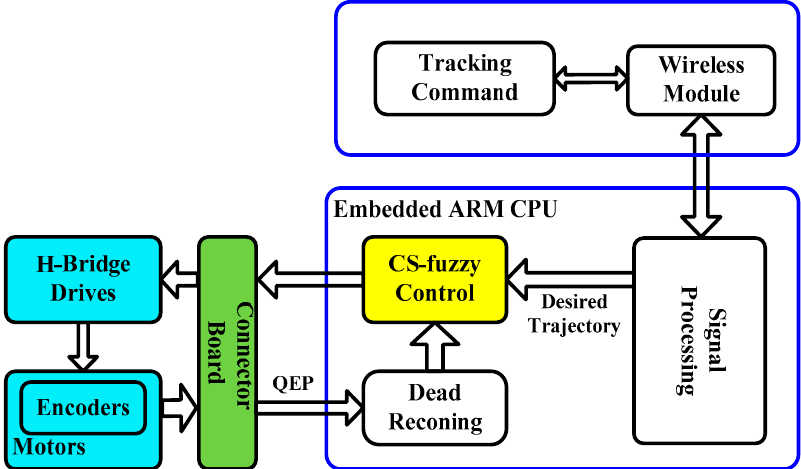
Figure 4. System structure of the omni-Mecanum-wheeled autonomous vehicle. (Quadrature encoder pulse = QEP).